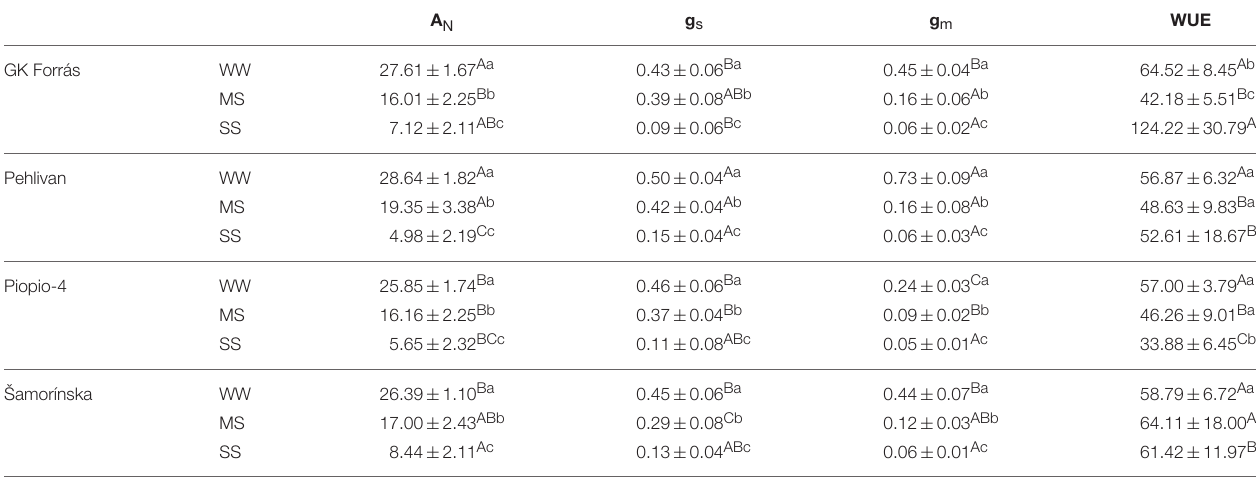
TABLE 2 | The net CO 2 assimilation rate (A N ; µ mol m − 2 s − 1 ), stomatal conductance to H 2 O (g s ; mol H 2 O m − 2 s − 1 ), mesophyll conductance to CO 2 (g m ; mol CO